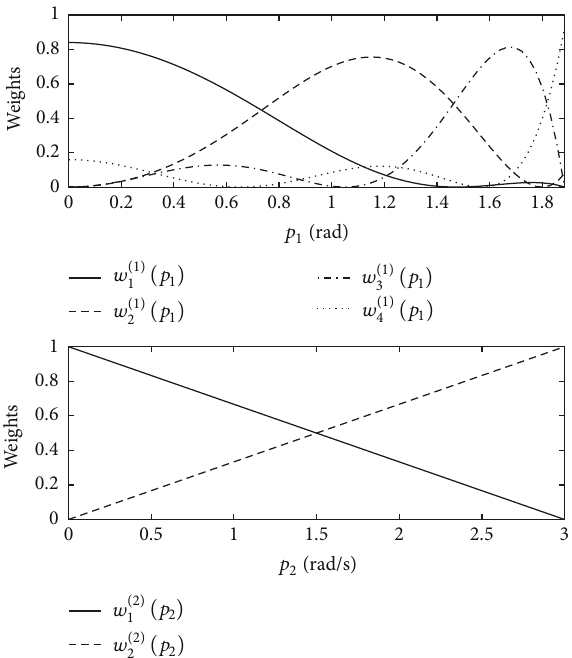
Figure 4: The w (1) (𝑝 1 ) and w (2) (𝑝 2 ) weighting functions in the polytopic TP